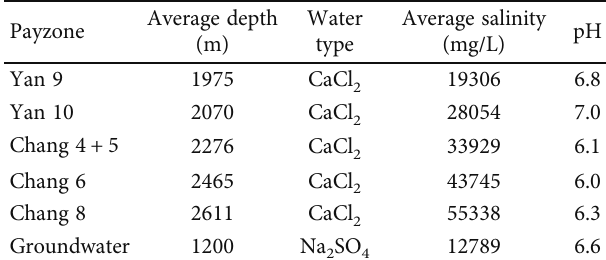
Figure 5: Ion concentrations of water samples by Table 1: Water sample analysis results by payzones.